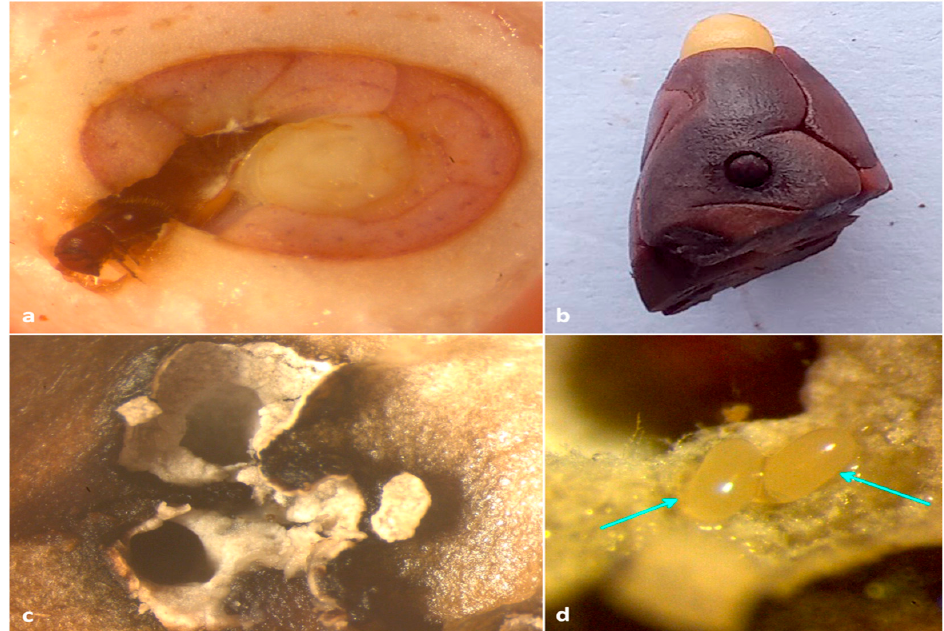
Figure 6. ( a ) adult X. crassiusculus boring on an immature cocoa bean; ( b ) adult X. crassiusculus tunneling on mature cocoa bean; ( c ) staining of insect galleries with whitish-grey fungal hyphae; ( d ) eggs of X. crassiusculus with fungal symbionts in cocoa bean.